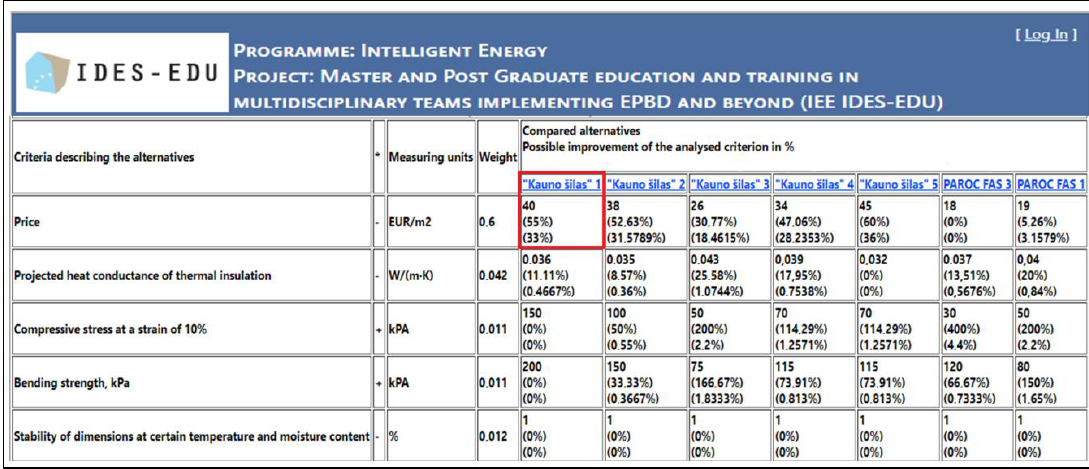
Figure 5. Fragment of advice for users.